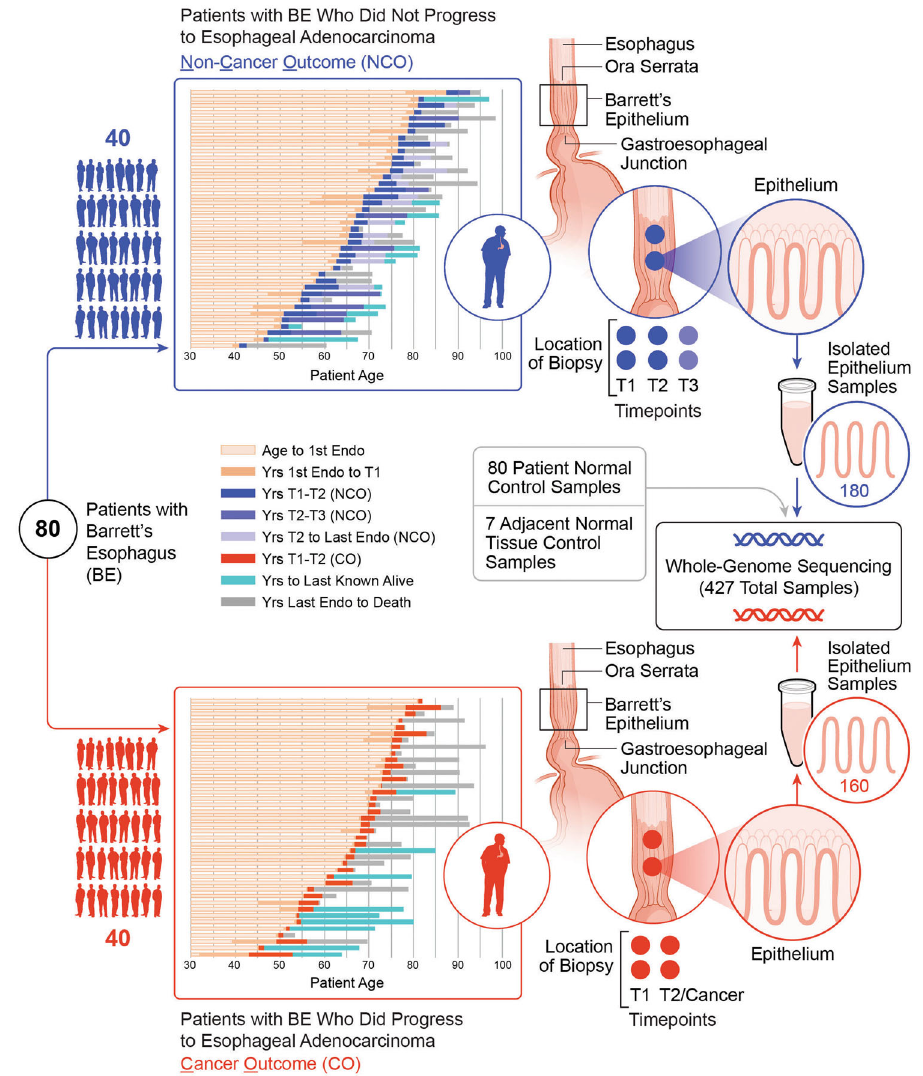
Fig. 1 Longitudinal multi-sample study in cases with BE who progressed to an ESAD outcome compared to controls with BE who did not progress. Schematic of our study including 340 spatially mapped BE biopsies and 87 normal control samples across 80 patients with diagnosed BE, including 40 controls with BE who did not progress to ESAD and 40 cases who progressed to an endoscopically detected, incident ESAD. Unless otherwise noted, results combine T1 and T2 time points and do not include NCO T3 or the seven additional adjacent normal gastric control samples. Source data are indicated in Figure Source Data